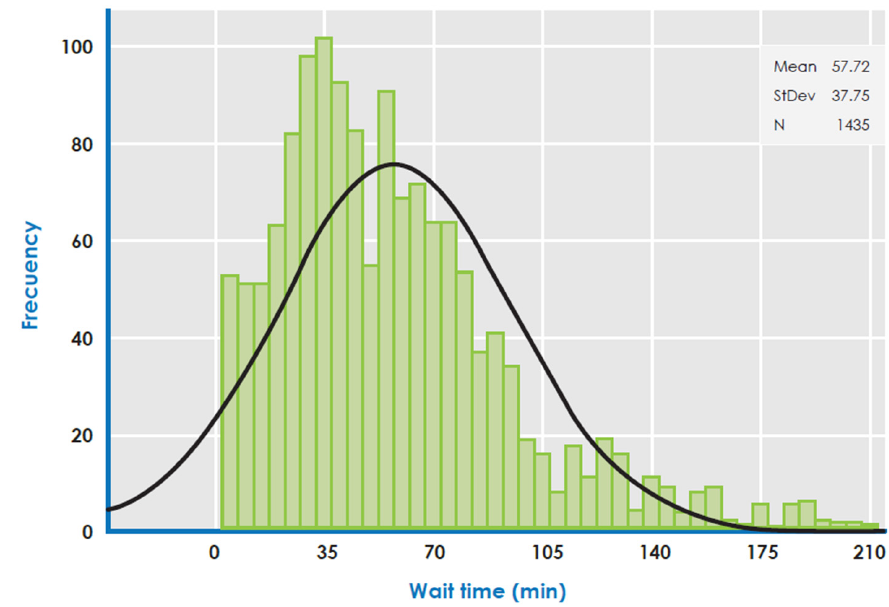
Figure 4. Histogram of supermarket waiting